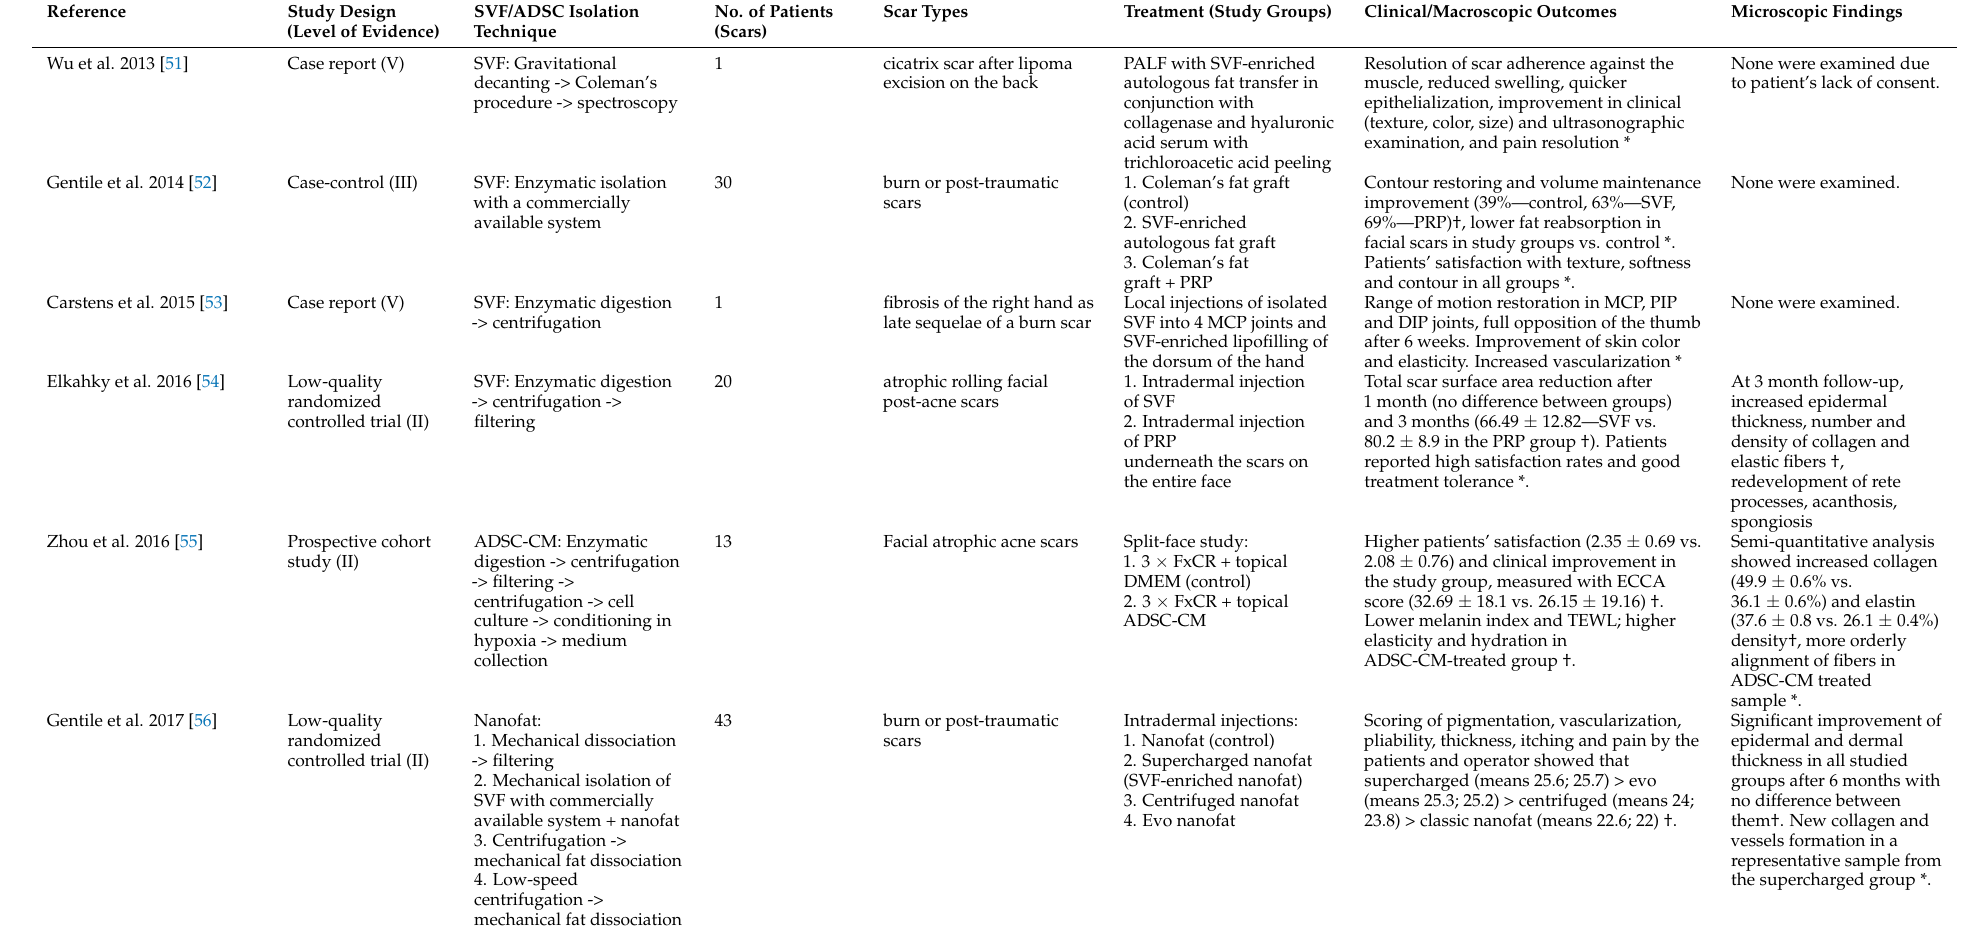
Table 1. Summary of design, SVF/ADSC isolation procedures, populations, interventions, clinical and microscopic outcomes of selected